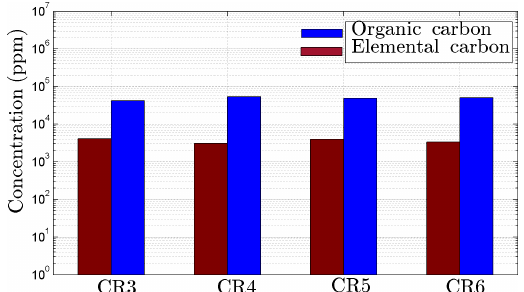
Figure 9. Concentration of organic carbon (blue bars) and elemental carbon (red bars) for different cryoconite samples